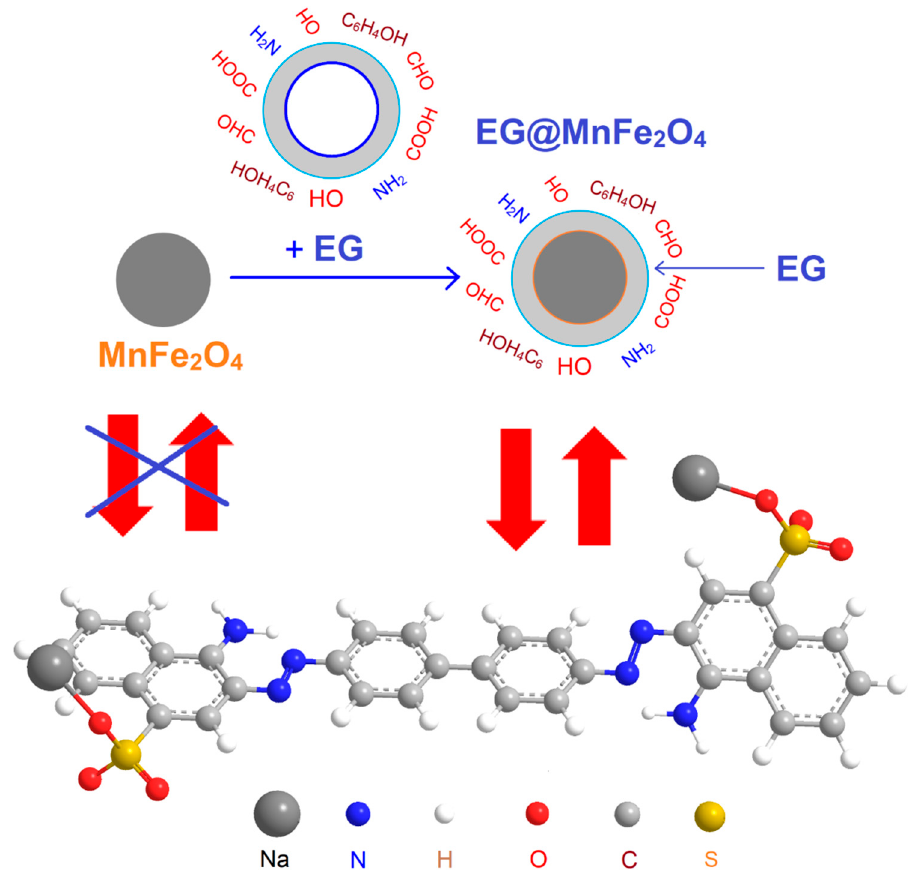
Figure 12. Proposed mechanism for the adsorption of CR onto EG@MnFe 2 O 4 .